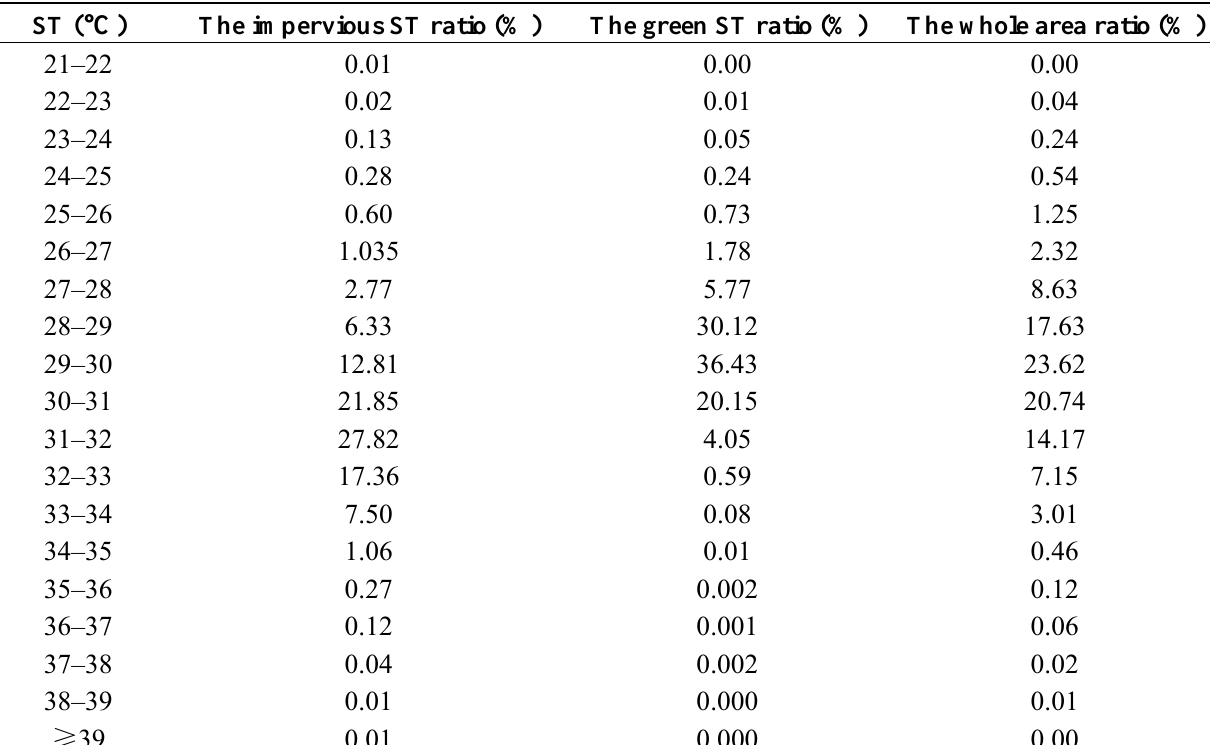
Table 1. The ratio of the ST in underlying surface